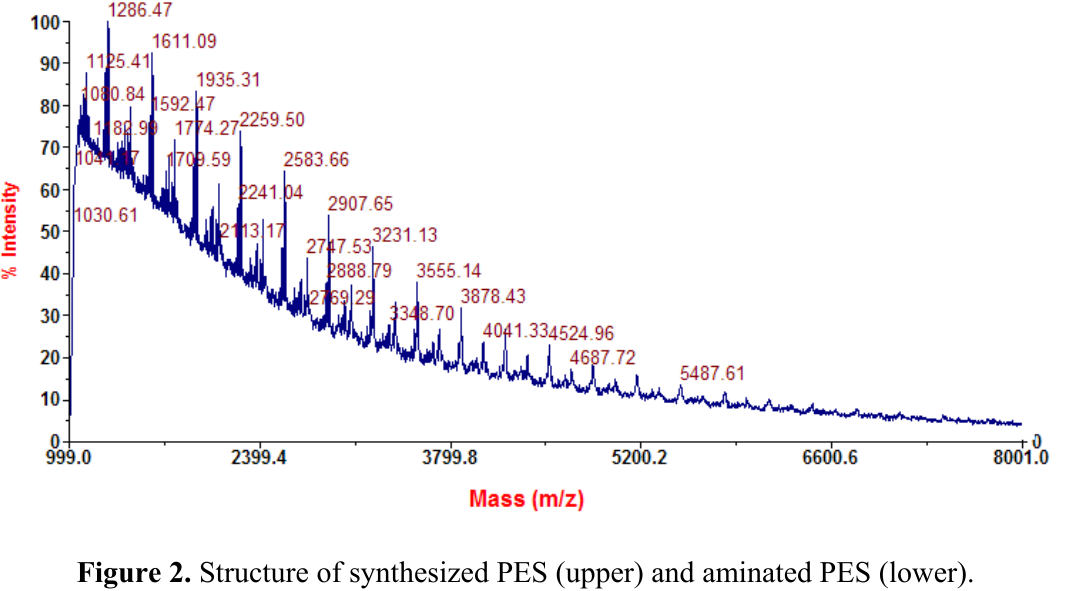
Figure 2. Structure of synthesized PES (upper) and aminated PES